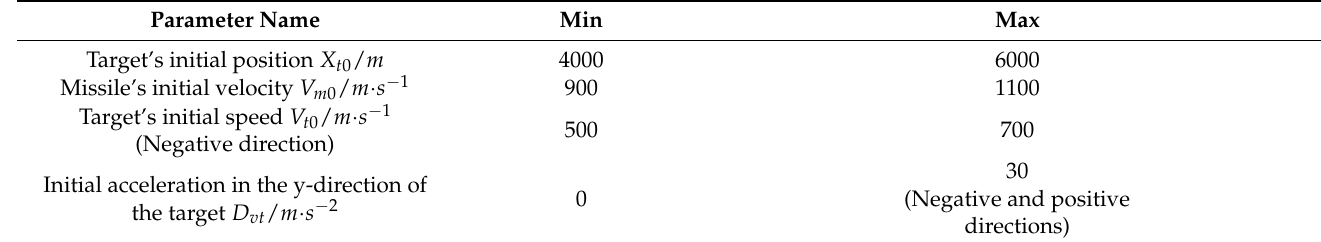
Table 2. Initial state values of the integrated 3D-guidance-and-control